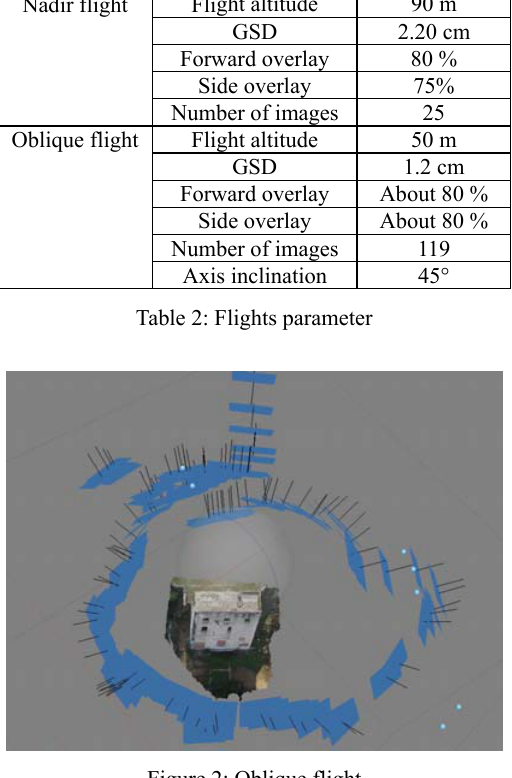
Figure 2: Oblique flight